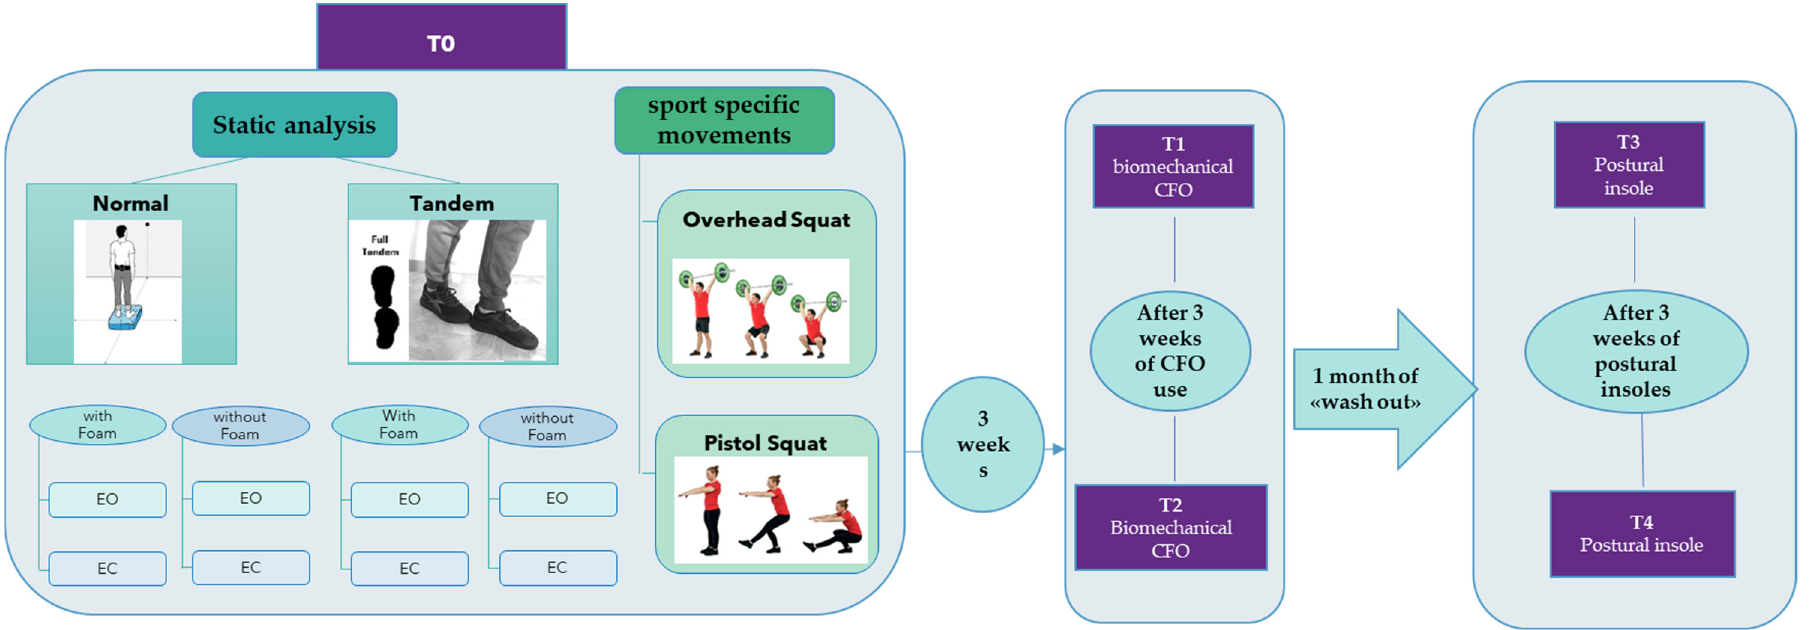
Figure 3. Graphical representation of the testing procedure. EO: eyes open; EC: eyes closed; CFO: custom foot orthoses; OHS: overhead squat; PS: pistol squat.